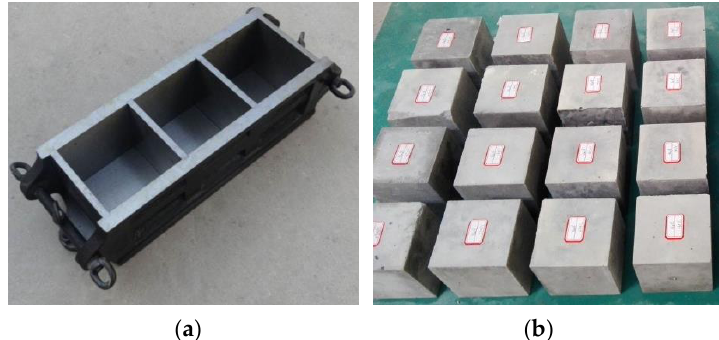
Figure 2. Manufacture of mortar samples: ( a ) Standard metallic cube mold; ( b ) Mortar specimens after curing 28 d.